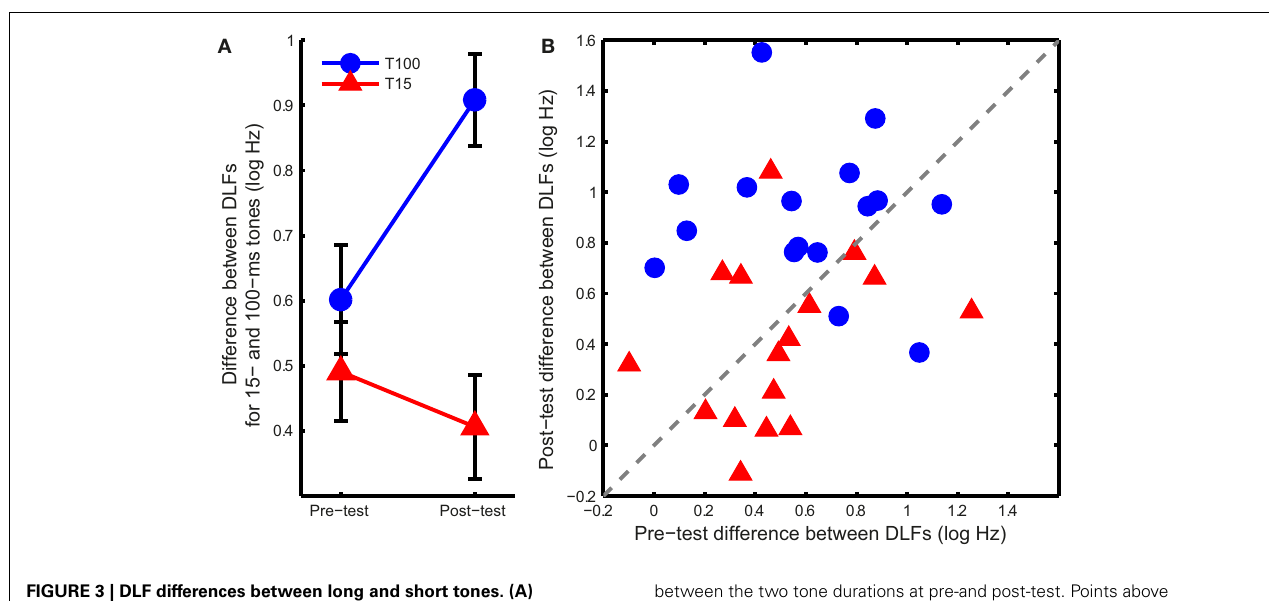
FIGURE 3 | DLF differences between long and short tones. (A) Mean ( ± SEM) difference in DLF for 15- and 100-ms tones at pre- and post-test in the two training groups. (B) Individual differences